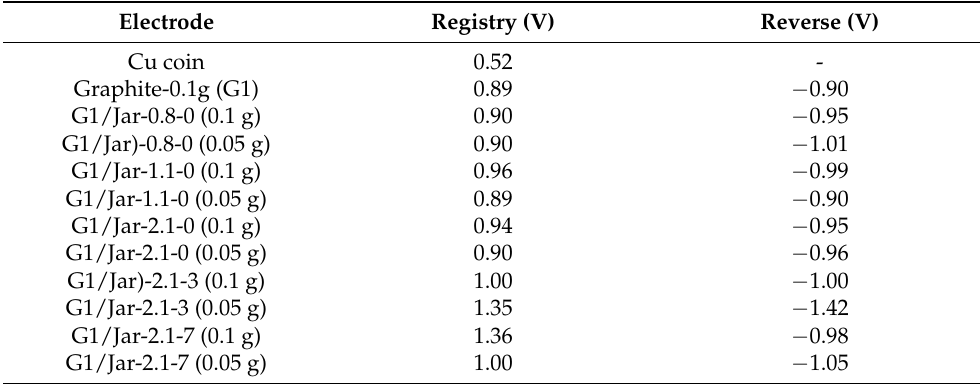
Table 5. Results obtained during the electrical test done on electrodes prepared with jarosite and graphite, using calcium chloride as